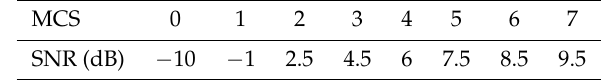
Table 4. Measured SNR against MCS